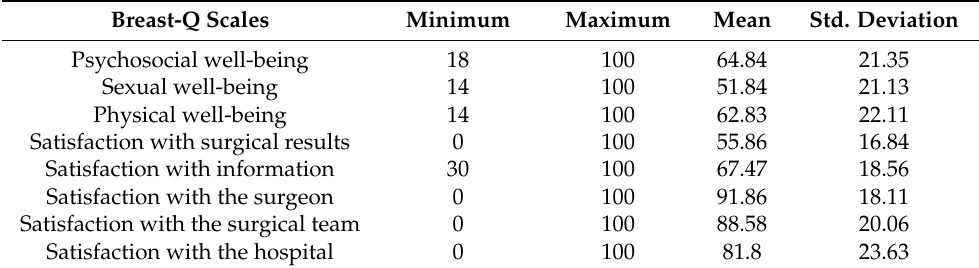
Table 4. Results of the BREAST -Q questionnaire.